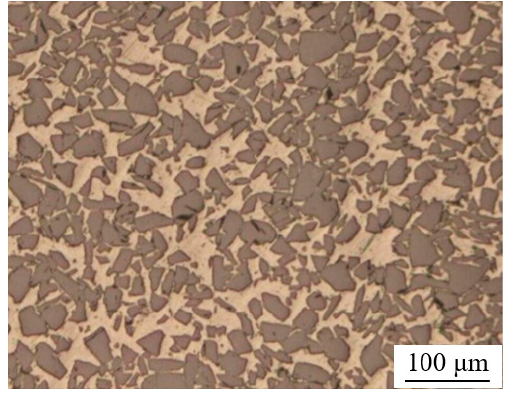
Figure 1. Metallographic structure of 65 vol.% aluminum matrix composites reinforced with SiC particles (SiC p / 6063 Al